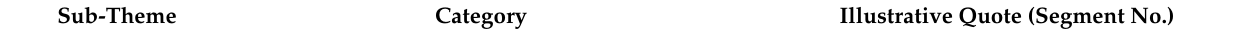
Table 5. Theme: Positive Effects of Communication in the Media: Sub-themes, Categories and Illustrative Quotes.